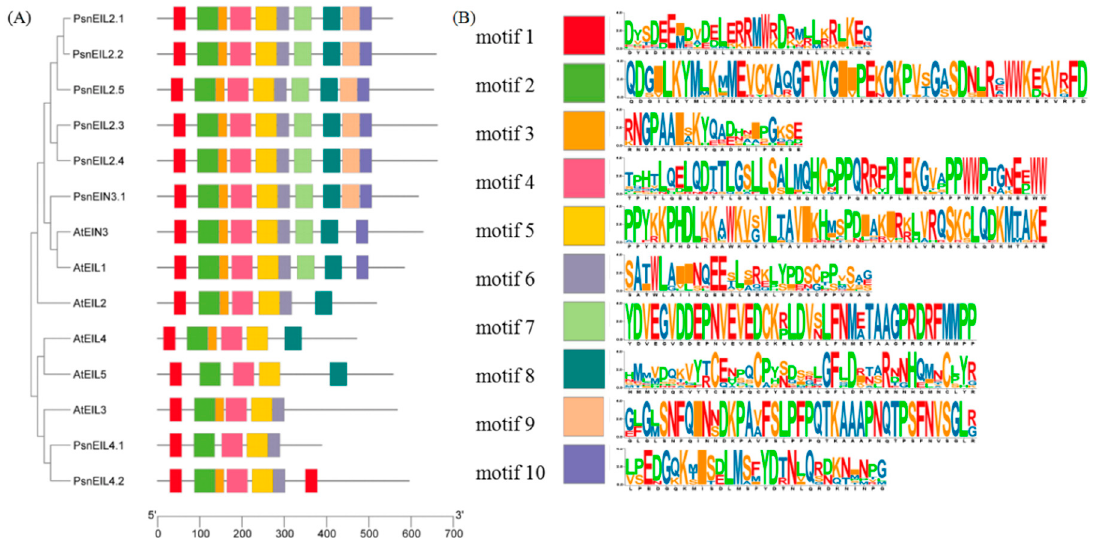
Figure 4. Analysis of the conserved motifs of EIN3/EIL genes in Populus × xiaohei and A. thaliana . Structural features of EIN3/EIL transcription factors in Populus × xiaohei and A. thaliana . ( A ) The NJ tree and motif analysis were constructed from a total of 14 EIN3/EIL genes from Populus × xiaohei and A. thaliana . The numbers below the motifs correspond to their approximate position and length in the residue. The EIN3 domain is located in the first half of the protein, between approximately 80 and 280 residues. ( B ) LOGO of 10 conservative motifs was predicted by the MEME tool.